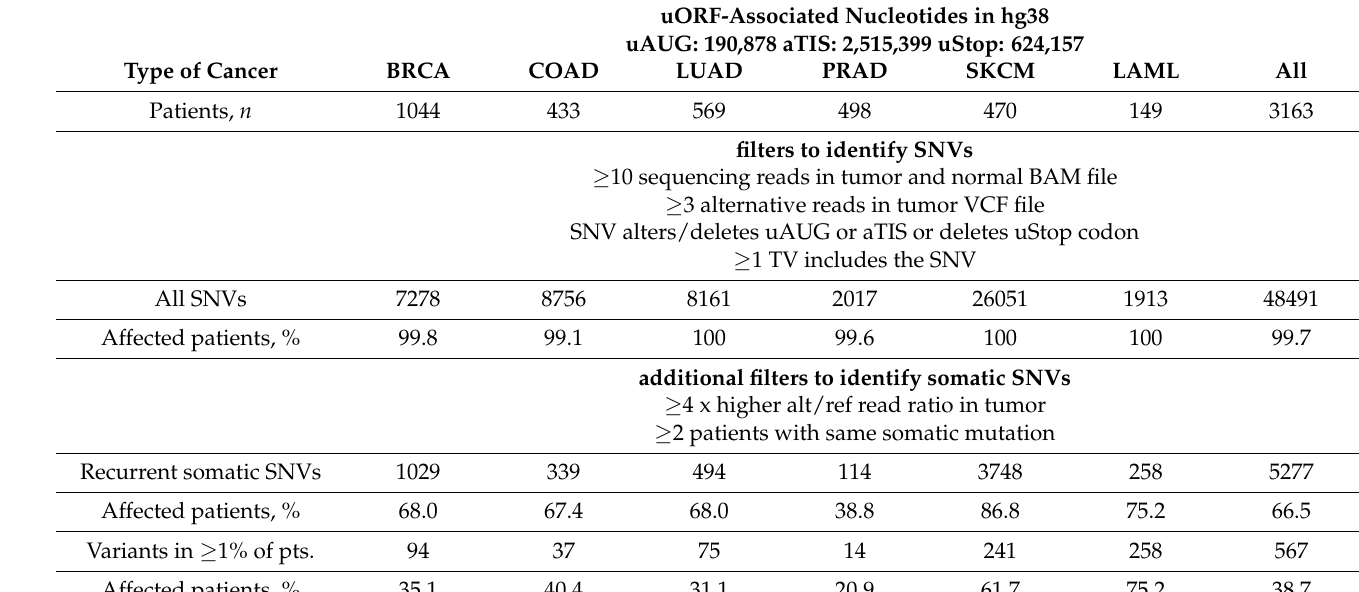
Table 1. Summary of screened uORF-associated genomic positions, analyzed types of cancer, and identified SNVs affecting uAUG, aTIS, and uStop codons.